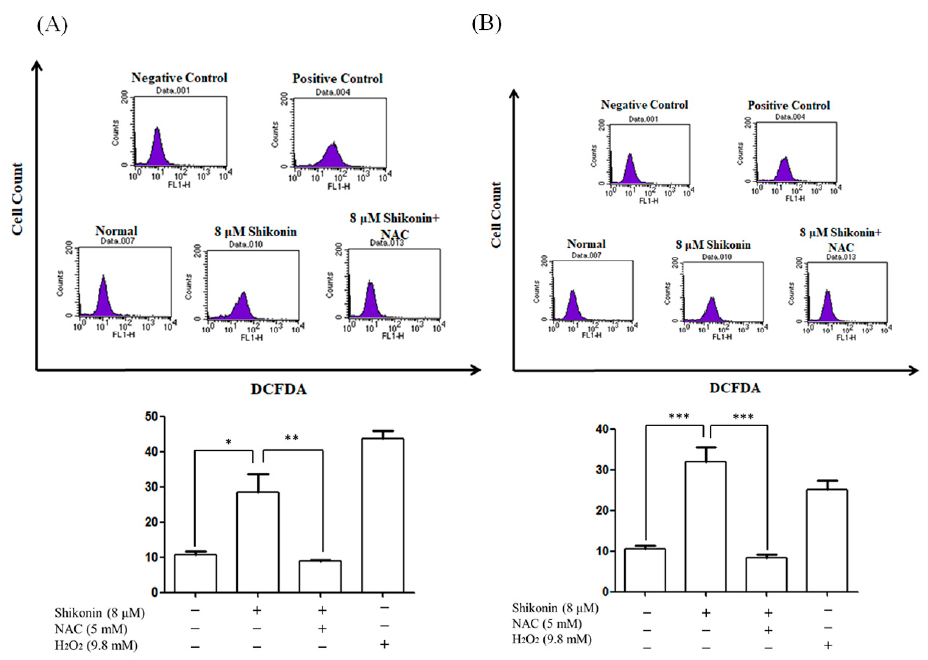
Figure 4. Shikonin enhanced reactive oxygen species (ROS) level in RCC cells. ( A ) ACHN and ( B ) Caki-1 cells were treated with 8 μ M shikonin for 24 h with or without pretreatment with NAC. The cells were stained with DCFH-DA and analyzed by flow cytometry. H 2 O 2 was used as the positive control. Data represent means ± standard deviation from at least three independent experiences. * p < 0.05, ** p < 0.01, and *** p < 0.001.